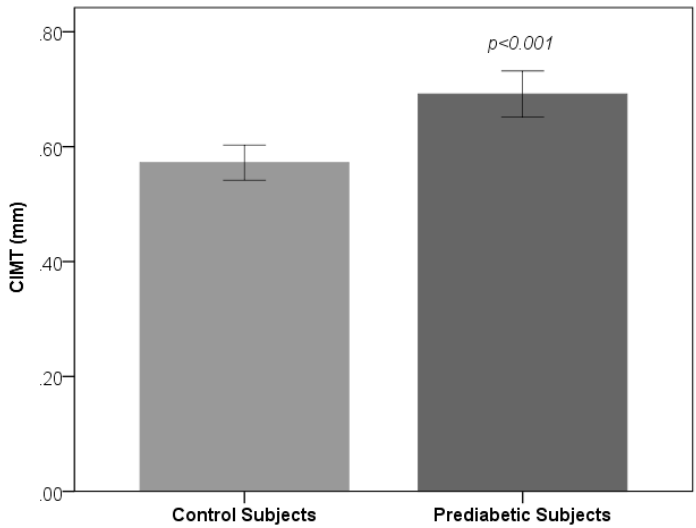
Figure 1. Comparison of Carotid intima-media thickness (CIMT) between control and prediabetic subjects.